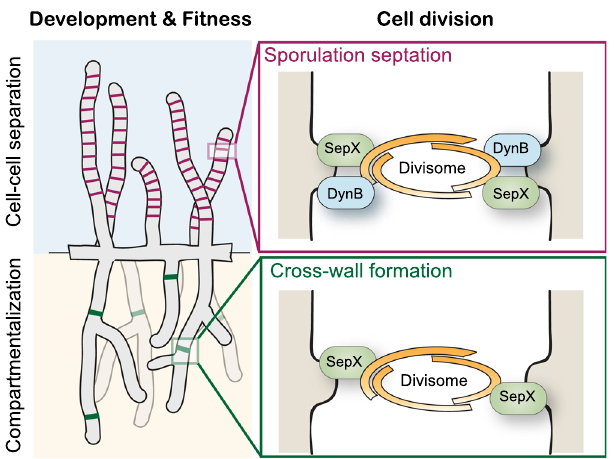
Fig. 7 Proposed model for SepX function in Streptomyces cell division. During vegetative growth, SepX is crucial for the establishment of stable Z-rings leading to cross-wall formation and the compartmentalization of the hyphae which in turn is required for the coordinated progression through the life cycle and overall fi tness of the organism. During reproductive growth, SepX functions together with the dynamin-like protein DynB to ensure the spatial con fi nement of Z-rings, thereby stabilizing divisome assembly, function and ef fi cient sporulation